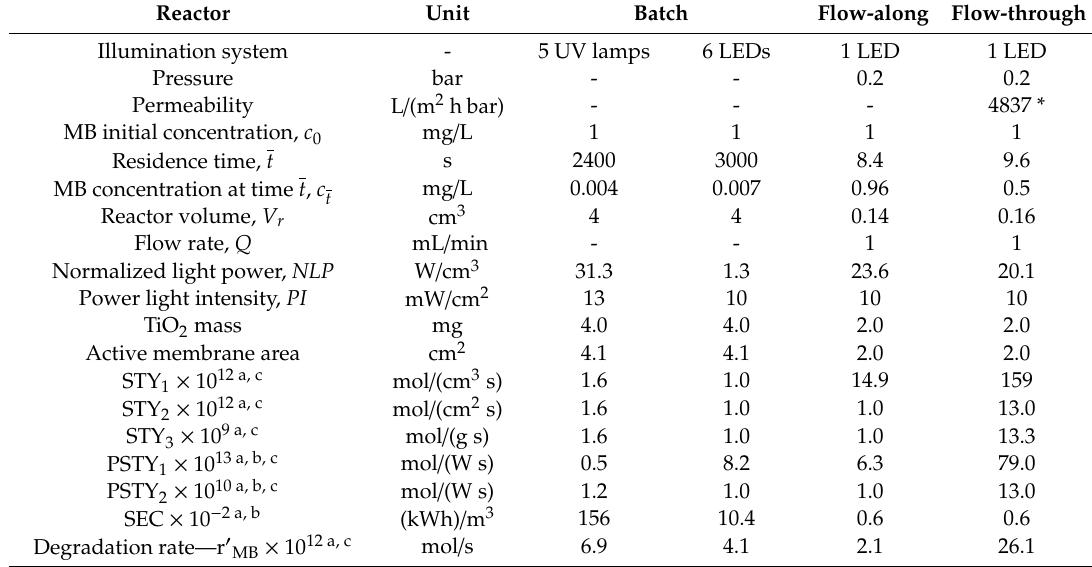
Table 3. Data and figure-of-merit summary of the batch, flow-along and flow-through reactors. Reactor Unit Batch Flow-along